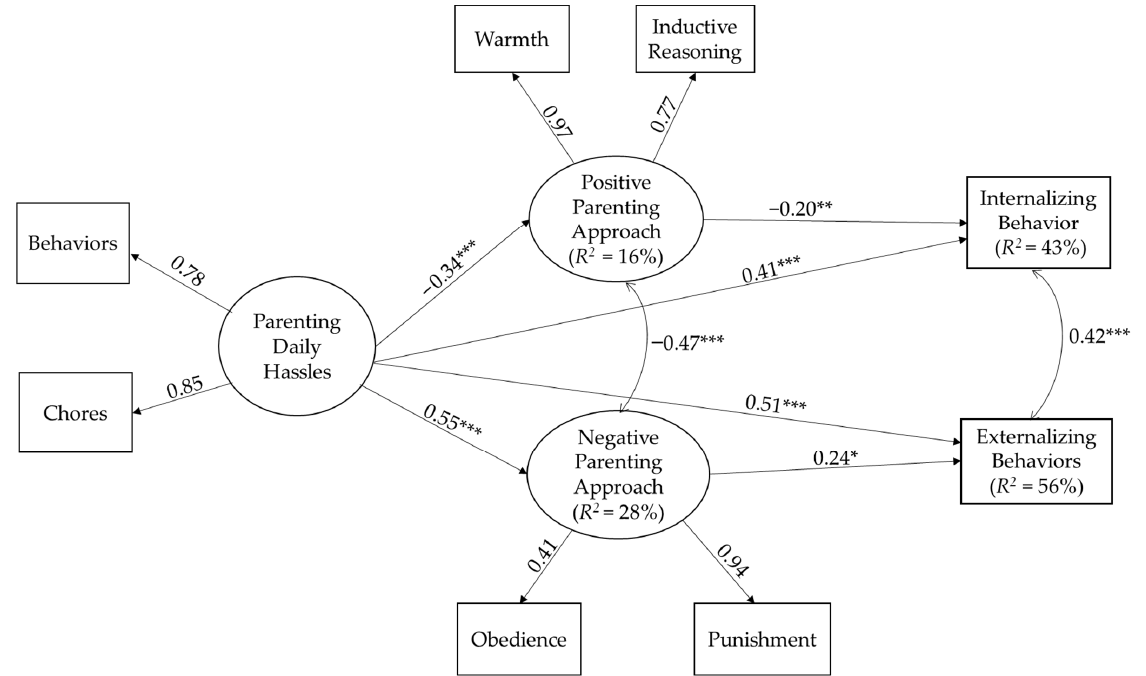
Figure 1. Parenting daily hassles predicting children’s internalizing and externalizing behaviors through positive and negative parenting approaches. *** p < 0.001, ** p < 0.01, * p < 0.05. Note. Only significant paths are depicted for brevity. Child sex (B = − 0.13, β = − 0.16, p < 0.01, favoring boys), child age (B = − 0.006, β = − 0.21, p < 0.001), family SES (B = − 0.07, β = − 0.15, p = 0.01), mother employment status (B = 0.15, β = 0.19, p < 0.01, favoring employed mothers) as a covariate was controlled for daily hassles. Child sex (B = 0.06, β = 0.11, p < 0.05, favoring girls) and child age (B = 0.002, β = 0.10, p < 0.05) as a covariate was controlled for the negative parenting approach. Fear of COVID-19 (B = 0.08, β = 0.19, p < 0.001) as a covariate was controlled for the negative parenting approach. Family SES (B = − 0.82, β = − 0.11, p < 0.05) and child age (B = − 0.04, β = − 0.10, p < 0.01) as a covariate was controlled for externalizing behaviors. Family SES (B = − 0.97, β = − 0.11, p < 0.05) and fear of COVID-19 (B = 1.27, β = 0.14, p < 0.01) as a covariate was controlled